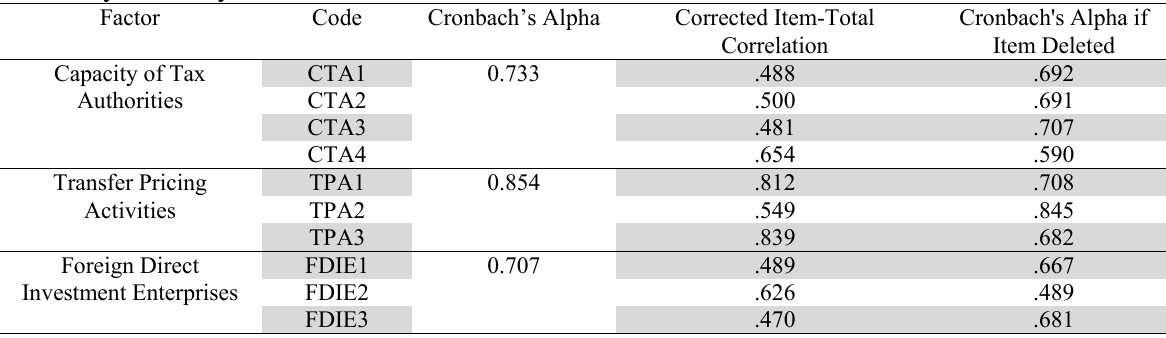
Reliability test